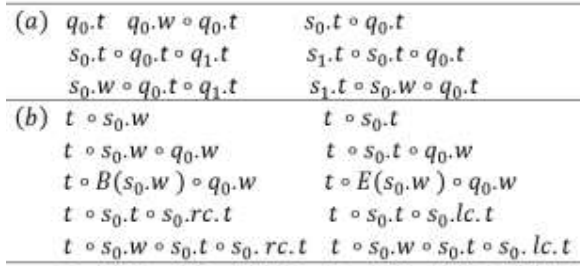
Figure 2. (a) List of delayed features for joint parser; (b) Syntactic features for the joint parser, where t is the POS tag to be assigned to q0